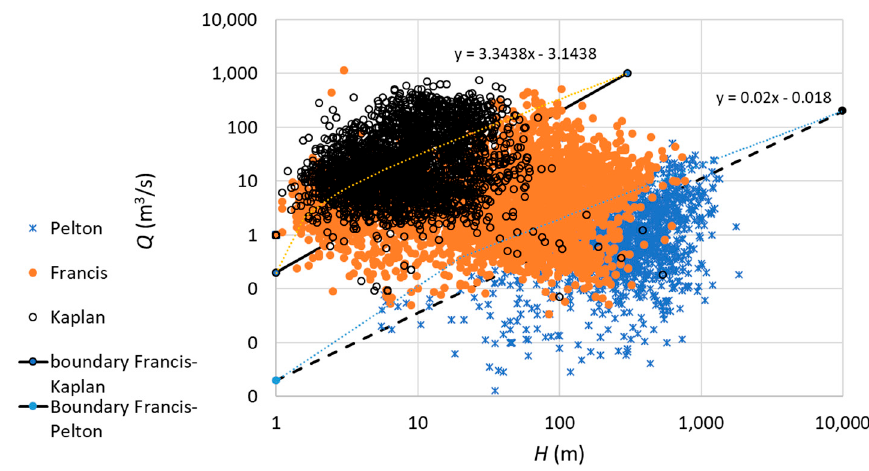
Figure 1. Range of Kaplan, Francis and Pelton turbines in the EU, based on flow rate Q and head H ([10], based on Voith Hydro), but without indication of the location. Table 1. Average number of units (No.) per power class (K = Kaplan, F = Francis, P = Pelton) (Source: Voith Hydro).